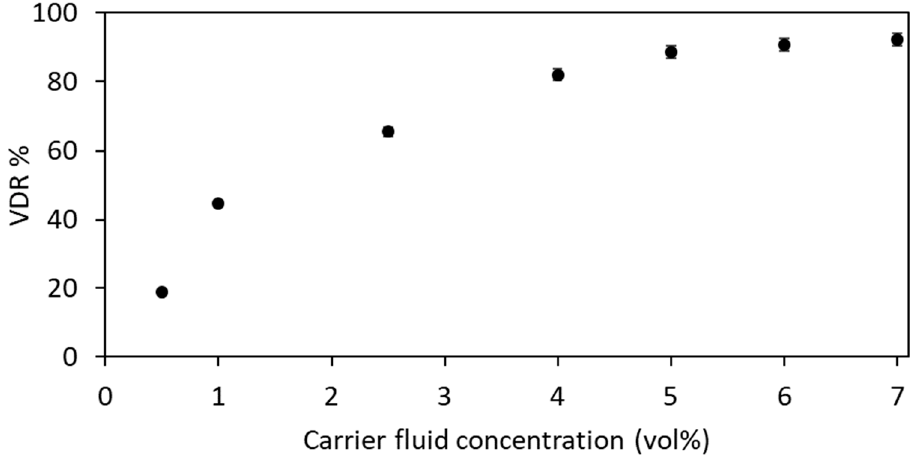
Figure 3. Effect of the carrier fluid dosage in the viscosity reduction degree (VRD) of an extra ‐ heavy oil at 30 °C for a fixed xylene/dimethylformamide ratio of 0.2 at a fixed shear rate of 10 s − 1.